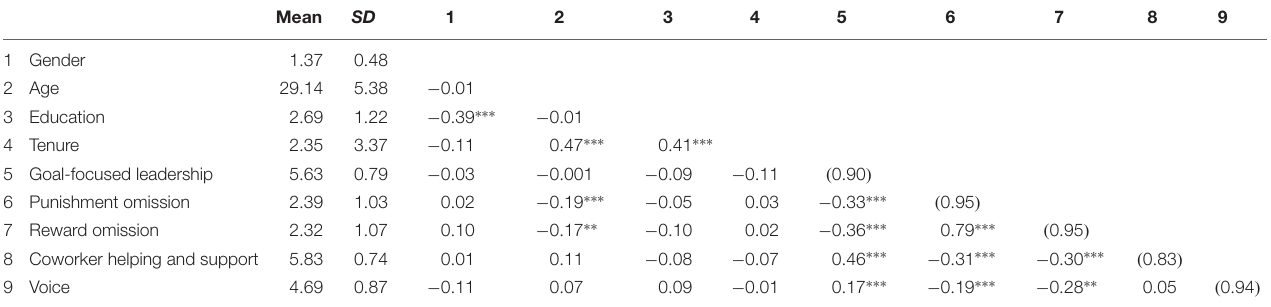
TABLE 2 | Means, standard deviations, reliabilities, and correlations among study variables.